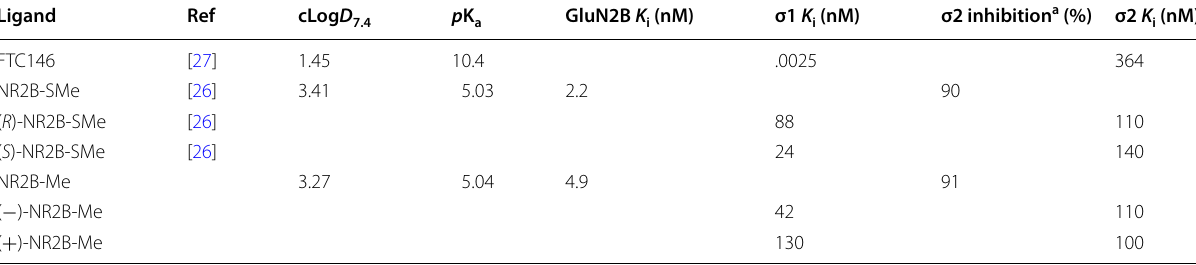
Table 1 Physical and pharmacological parameters of FTC146, NR2B‑SMe, NR2B‑Me, and their